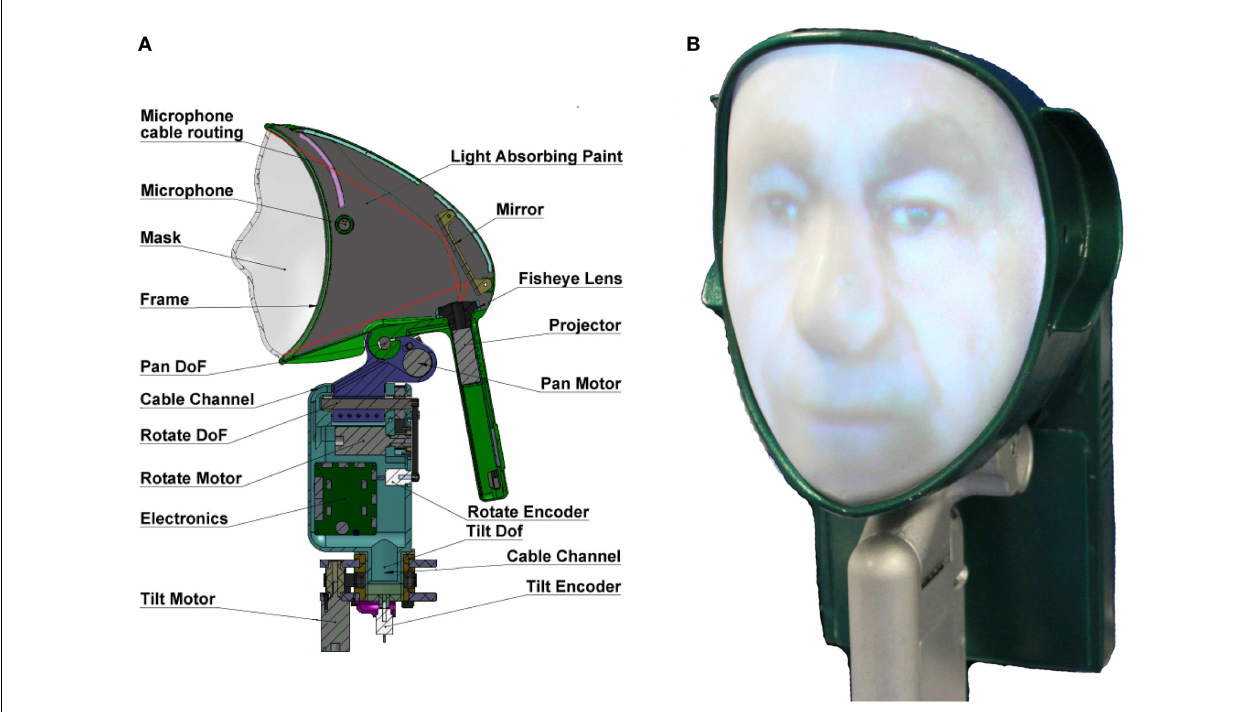
FIGURE 5 | The head of Herbert (A) Cut through of the CAD model of the head. (B) The final head with the avatar projected onto the